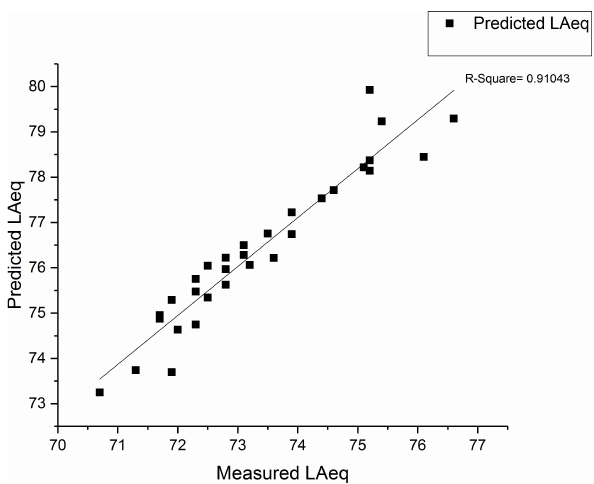
Figure 12: Measured L Aeq vs L Aeq − Predicted with horn correction